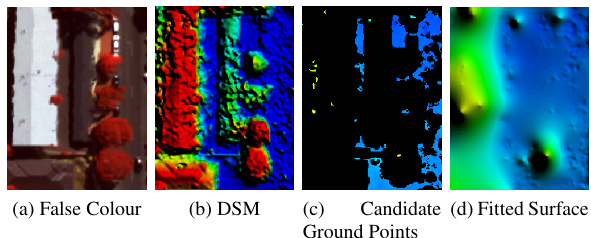
Figure 4. An example of a surface fitted to an inflows candidate ground mask. Shown is a false colour display of the region (a), the DSM (b), the set of cgp from inflows (c) and the fitted surface (d). The sub-figures (b), (c) and (d) are coloured according to the same height scale (blue = low, red = high). The surfaces (a) and (d) are also sun-shaded to accentuate texture. In (c) the black pixels are those that were not candidate ground. A few high, non- ground, pixels (coloured green or yellow due to their height) can be seen in (c); they are causing the large mound-like features in (d).